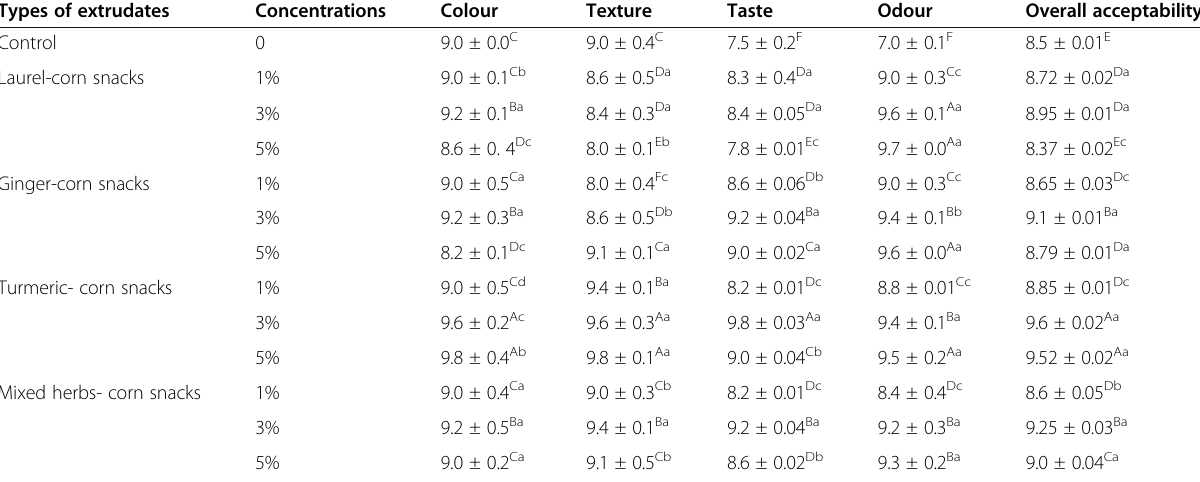
Table 2 Sensory quality score of extruded fortified corn snack Types of